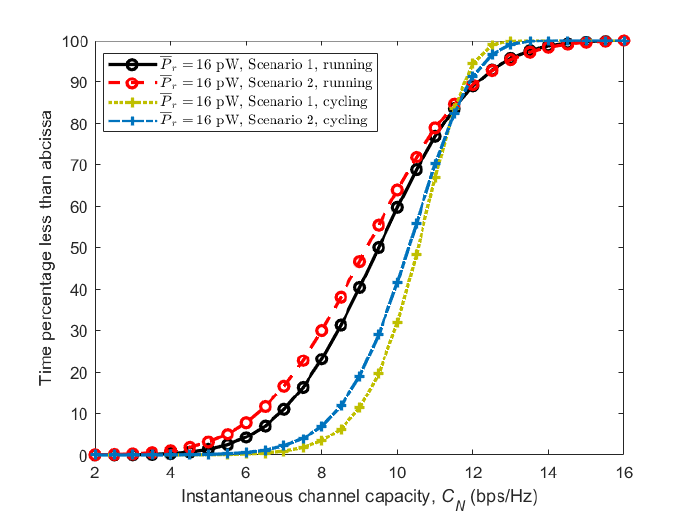
Figure 13. CDFs of channel capacity C for all scenarios during running and cycling activities with average received power P r = 16